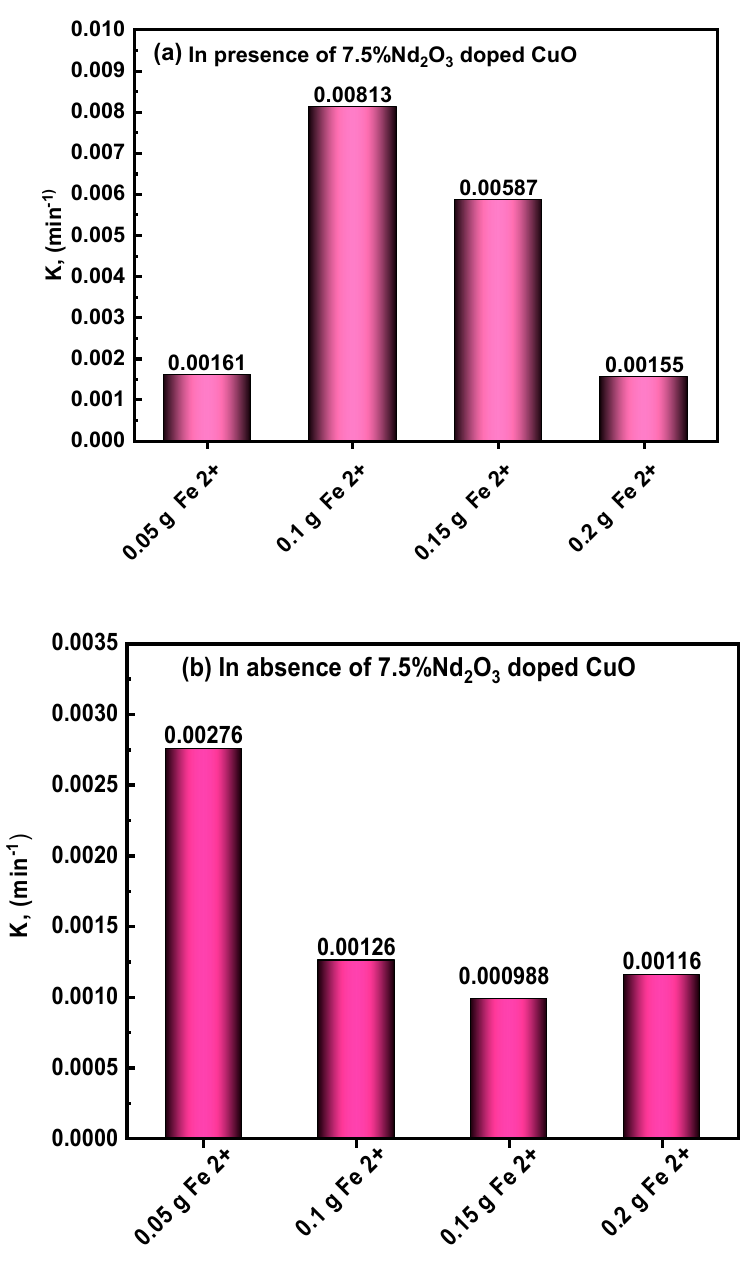
Figure 9. TherateconstantPhoto-Fenton, ( a )withand( b )without7.5%Nd 2 O 3 dopedCuOnanocomposites. Figure 9. The rate constant Photo-Fenton, ( a ) with and ( b ) without 7.5% Nd2O3 doped CuO nanocomposites. The result showed that the optimum rate constant was 0.00276 min − 1 at 0.05 g of Fe +2 ions concentration without a catalyst. The constant rate in the presence of a catalyst is higher than the absence of them. The rate constant ( k ) values and degradation (%) at different Nd 2 O 3 concentrations, H 2 O 2, and pH were calculated and tabulated in Table 4. The reaction in Fenton was initially identified by H.J. Fenton [28] and is classified as an improved oxidative potential for H 2 O 2 in acidic media when iron (Fe) is a catalyst. The reactions included in Fenton processes are